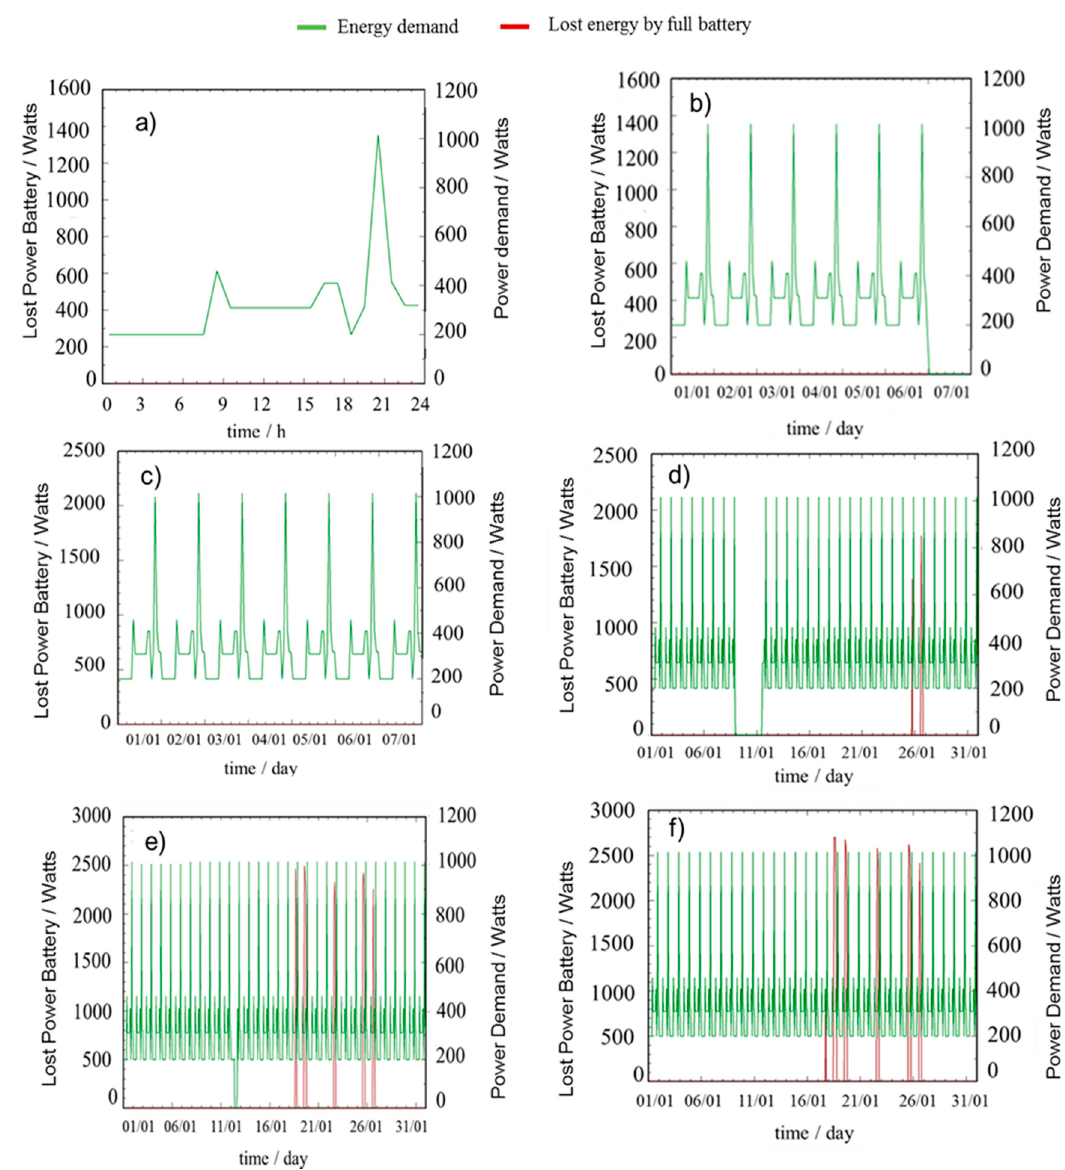
Figure 3. January supplied electrical demand by ( a ) sixteen PV modules for the 1st day, ( b ) sixteen PV modules for the first week, ( c ) twenty-two PV modules for the first week, ( d ) twenty-two PV modules for the full month, ( e ) twenty-eight PV modules for the full month, ( f ) thirty PV modules for the full month.